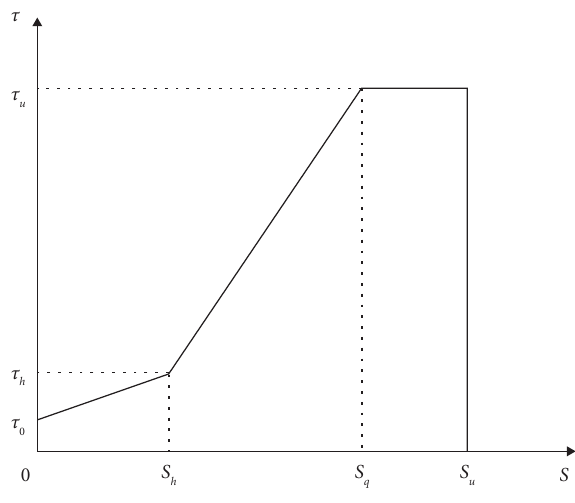
Figure 11: Te interfacial bond-slip model. Table 7: Te Interfacial bond strength, bond stifness, and